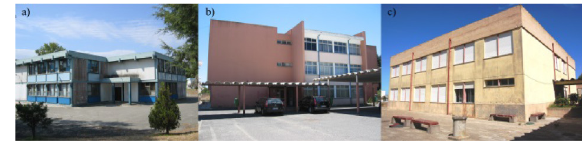
Fig. 2. Pavilion-type characteristic from sub-typologies a) A; b) B; and c) C